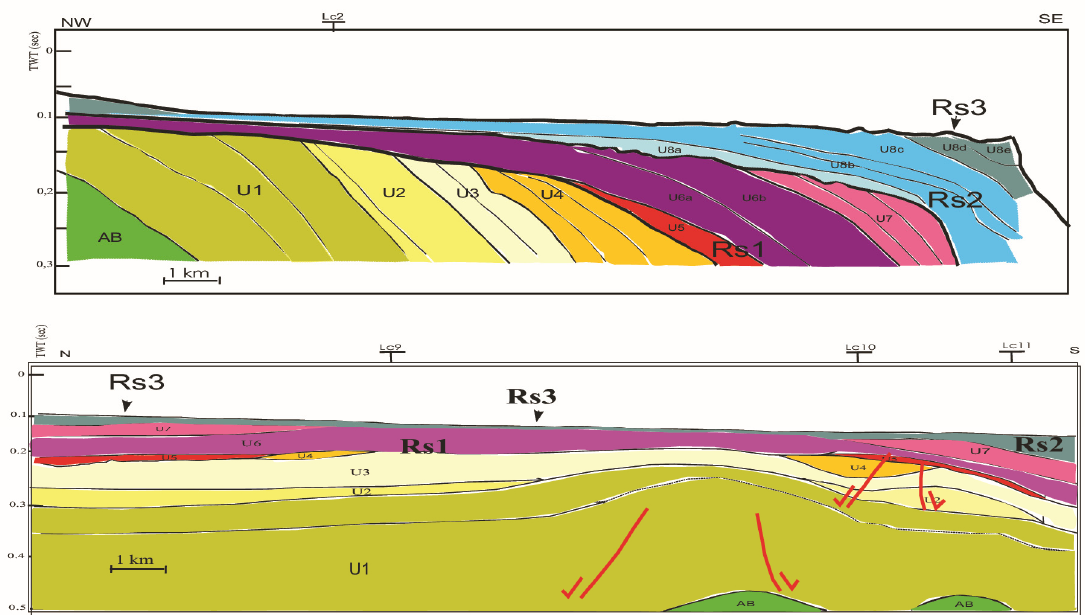
Figure 6. Scheme of the stratigraphic relationships constructed based on the interpretation of profiles shown in Figure seismic profiles shown in Figure 5.